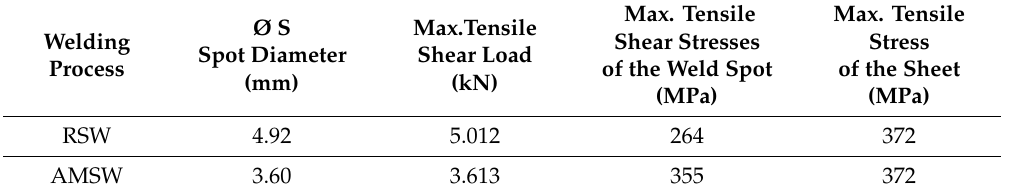
Table 6. Maximum tensile shear stress of the weld spots and the sheet (average of three